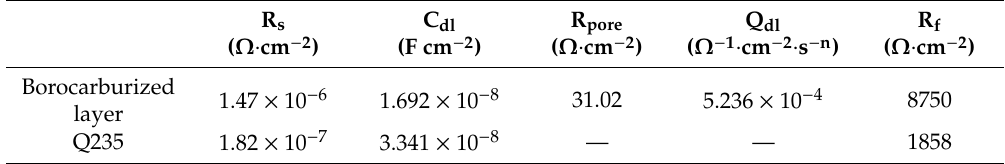
Table 2. EIS fitting results of the substrate and borocarburized